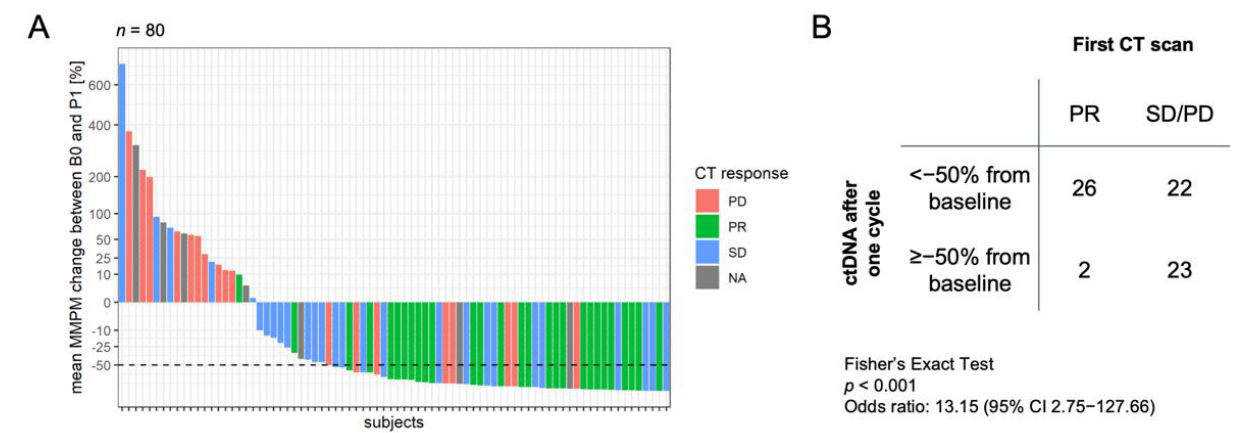
Figure 2. Association between first response assessment and ctDNA decrease after one chemotherapy cycle. ( A ) Waterfall plot showing change in ctDNA level at post-chemotherapy cycle 1 (P1) from baseline (B0). ctDNA levels were measured as mean mutant molecules per milliliter (MMPM). Each bar is colored by the first available response assessment after initiation of therapy: partial response (PR), stable disease (SD), progressive disease (PD), or CT scan not available (NA). Dotted line indicates the threshold of 50% decrease in mean MMPM. ( B ) Contingency table shows classification of response by ctDNA using a >50% decrease threshold vs. response by CT scan. p -value and odds ratio were calculated with Fisher’s Exact Test.